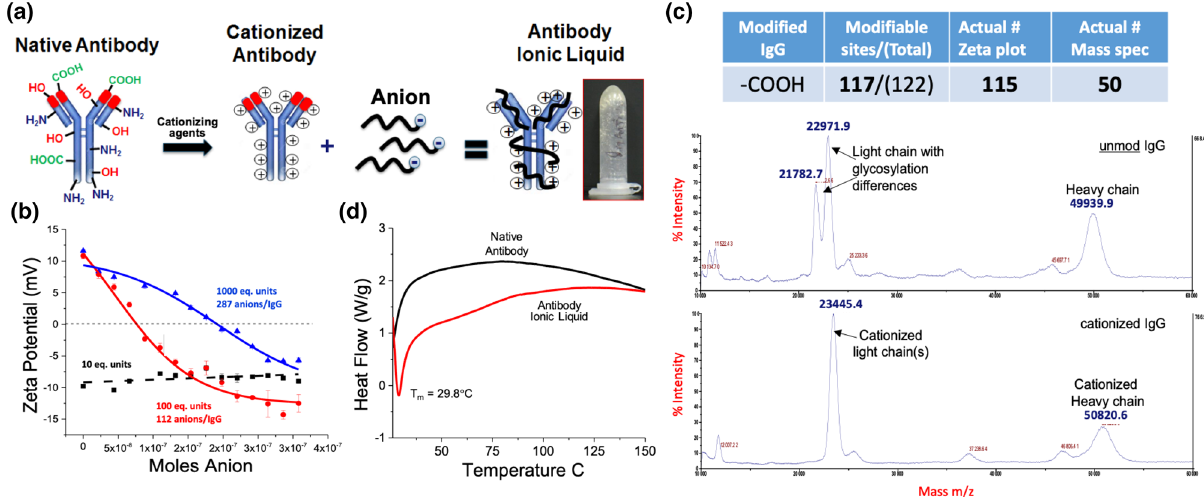
Figure 1. ( a ) Graphical representation of the method to produce antibody ionic liquid (IgG-IL). ( b ) Zeta potential charge analysis showing the differential impact of the free anion alone (10 equivalent units = 10 eq. units), 100 eq. units of free anion and cationized IgG (formulation utilized in the biocompatibility experiments described within this manuscript), and 1000 eq. units of the IgG-IL with respect to number of free anions added in solution. ( c ) MALDI mass spectrometry and ( d ) differential thermal analysis (DTA) material characterization IgG-IL (100 eq. units of free anion) highlighting the absorbance shifts in the peak intensities for the unmodified IgG antibody and the cationized